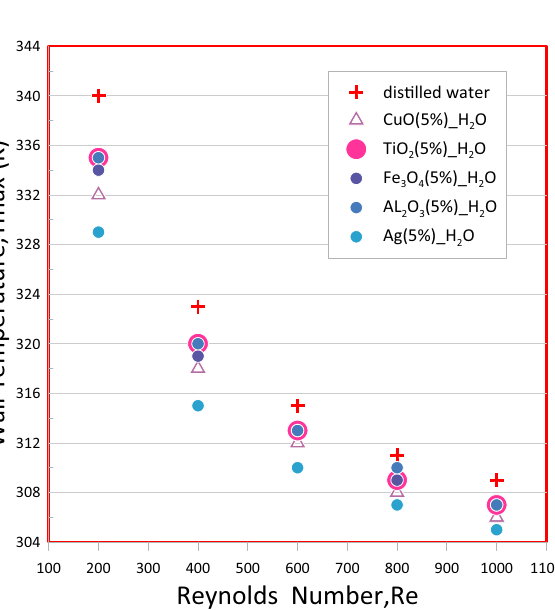
Figure 17. Friction factor of the wavy channel (A = 0.15 mm) and volume concentration (ϕ = 5%) for various nanofluids with Reynolds Number.